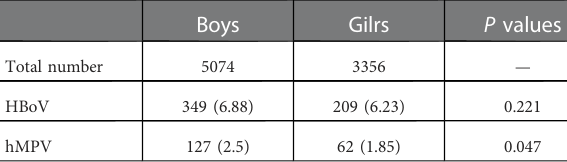
TABLE 2 Detection of HBoV and hMPV by gender [ n